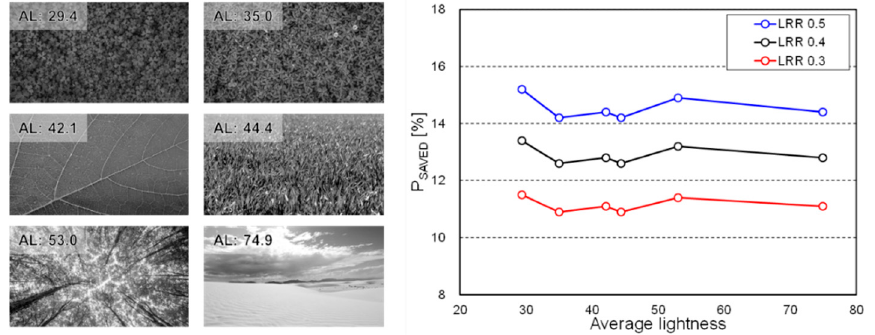
Figure 13. The additional images (left) and the P SAVED values after applying the peripheral dimming (right).